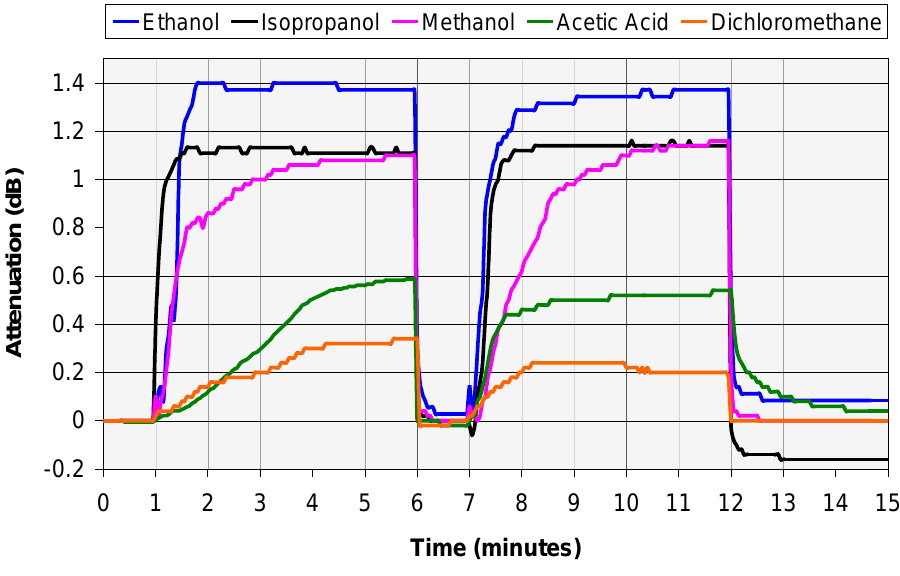
Figure 7. Attenuation of the reflected optical power when the sensor head is exposed to different VOCs and interrogated with a LED source at 850